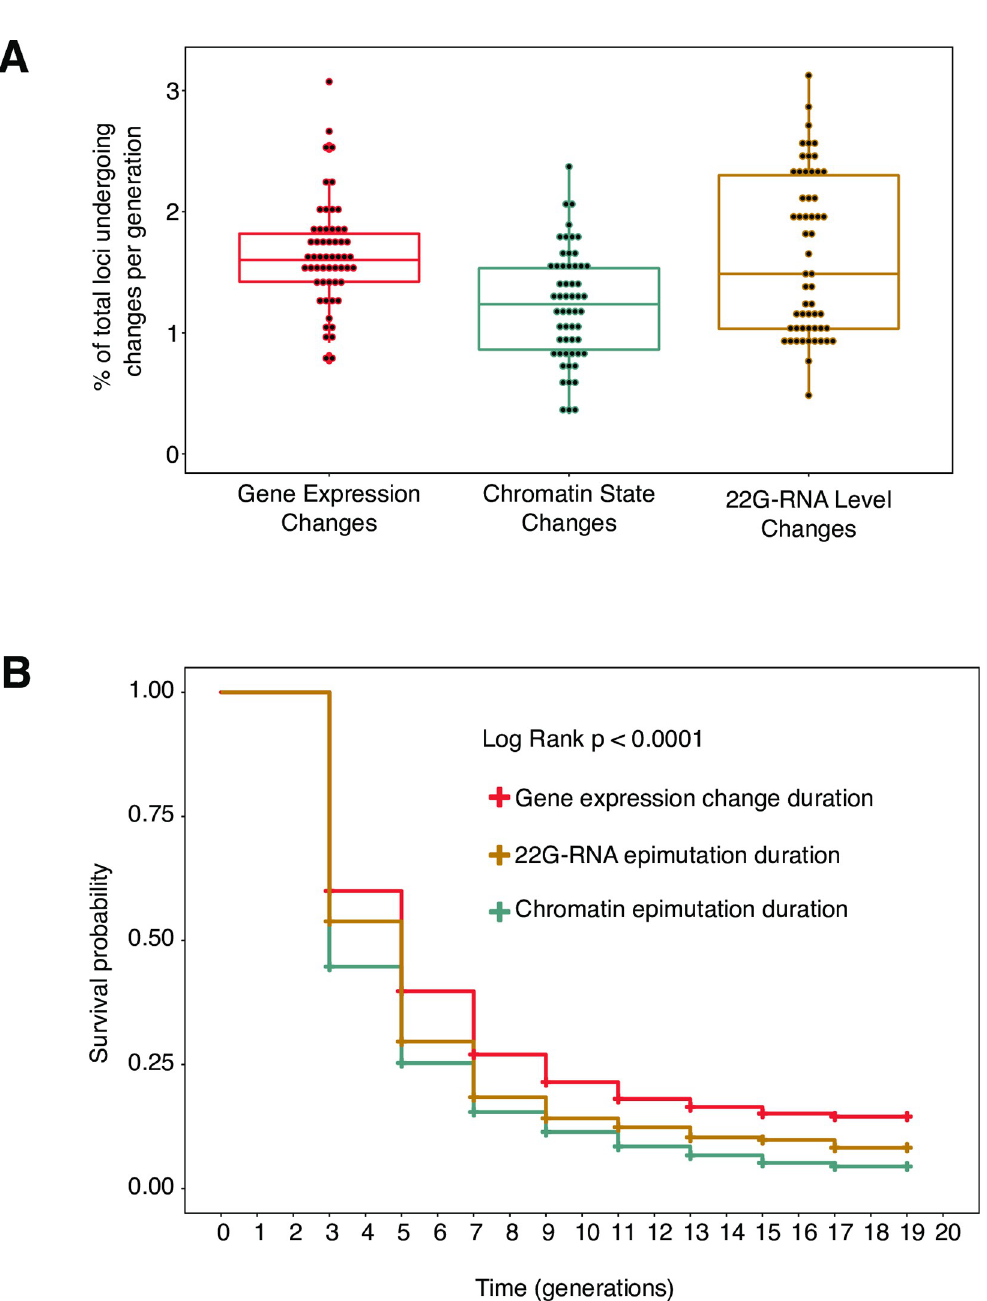
Fig 2. Rate of onset and survival of gene expression changes, chromatin and 22G-RNA-based epimutations. A. Boxplots indicate percentage of loci per generation subject to gene expression changes (red), chromatin state changes (blue) or 22G-RNA level changes (gold). Box shows the interquartile range with horizontal line at the median; the whiskers extend to the furthest point no more than 1.5 times the interquartile range B. Survival plot shows step changes in survival of gene expression changes (red), 22G-RNA-based epimutations (gold) and chromatin-based epimutations (blue) persisting over a time frame of 20 generations (generational time points on X-axis). Y-axis showing survival probability. p-value calculated with log rank